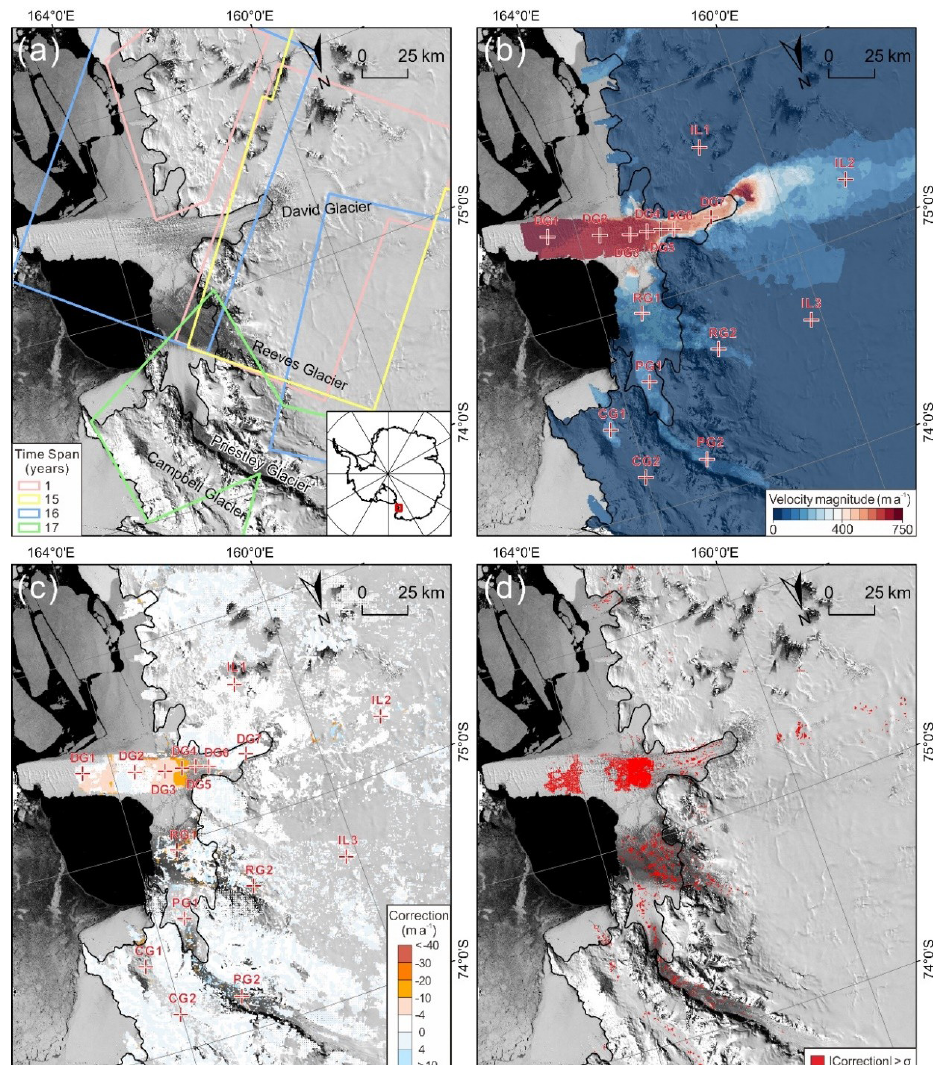
Figure 6. Application of the overestimation correction method to a historical velocity map of 1972–1989 of the David Glacier region, East Antarctica. (a) Footprints and time spans of the Landsat image pairs used for velocity mapping with a background of Landsat Image Mosaic of Antarctica (Bindschadler et al., 2008), (b) produced velocity map of 1972–1989 and selected points for examination of velocity overestimation and correction, (c) overestimation values of all velocity points generated using the image-feature-matching technique, and (d) velocity points with OE ≥ 1 σ (red